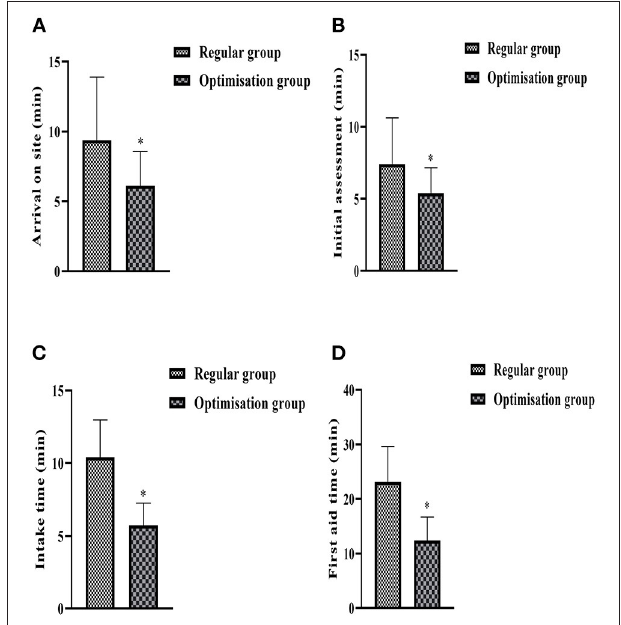
FIGURE 1 | Histogram comparing the indicators related to the two groups of first aid. (A) Shows the time spent on arrival at the scene. (B) Shows the time taken to assess the condition on site. (C) Shows the time taken to receive a consultation after admission to hospital. (D) Shows the time taken for first aid. *Denotes comparison with regular group, P <